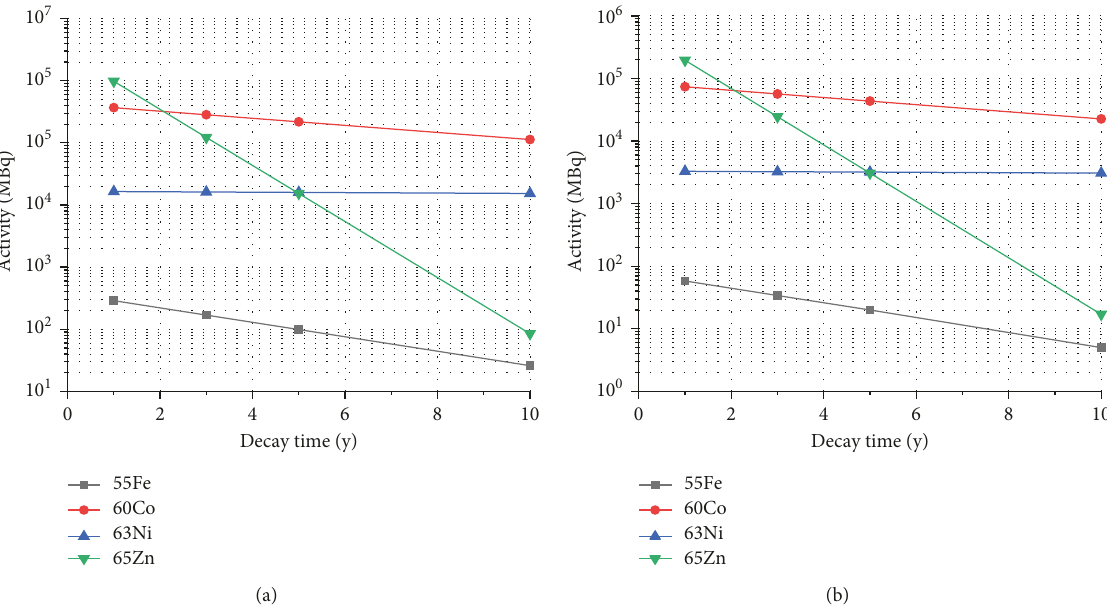
Figure 9: (a) Activity of long-lived nuclides in aluminum of the reactor reflector and (b) activity of long-lived nuclides in aluminum of the rest of the reactor.